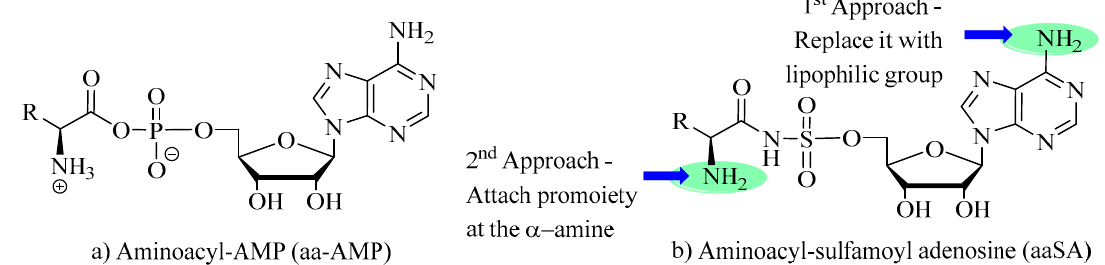
Figure 1. The general structure of natural reaction intermediate aminoacyl-adenylate (aa-AMP) and Figure1. The generalstructureof natural reaction intermediateaminoacyl-adenylate (aa-AMP)and their their 5'- O -( N -( L -aminoacyl)) sulfamoyladenosines (aaSA) analogues with the proposed site of 5 (cid:48) - O -( N -(L-aminoacyl)) sulfamoyladenosines (aaSA) analogues with the proposed site of modifications.